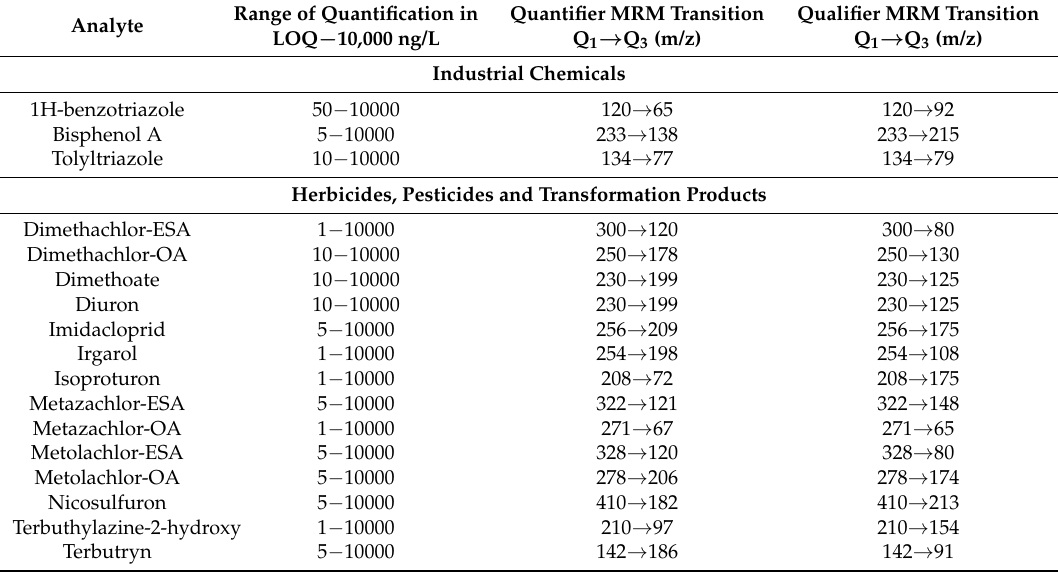
Table 1. List of analyzed emerging pollutants with range of quantification and MRM transitions.